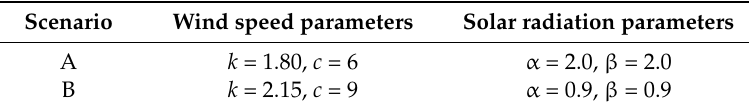
Table 6. Definition of two scenarios.